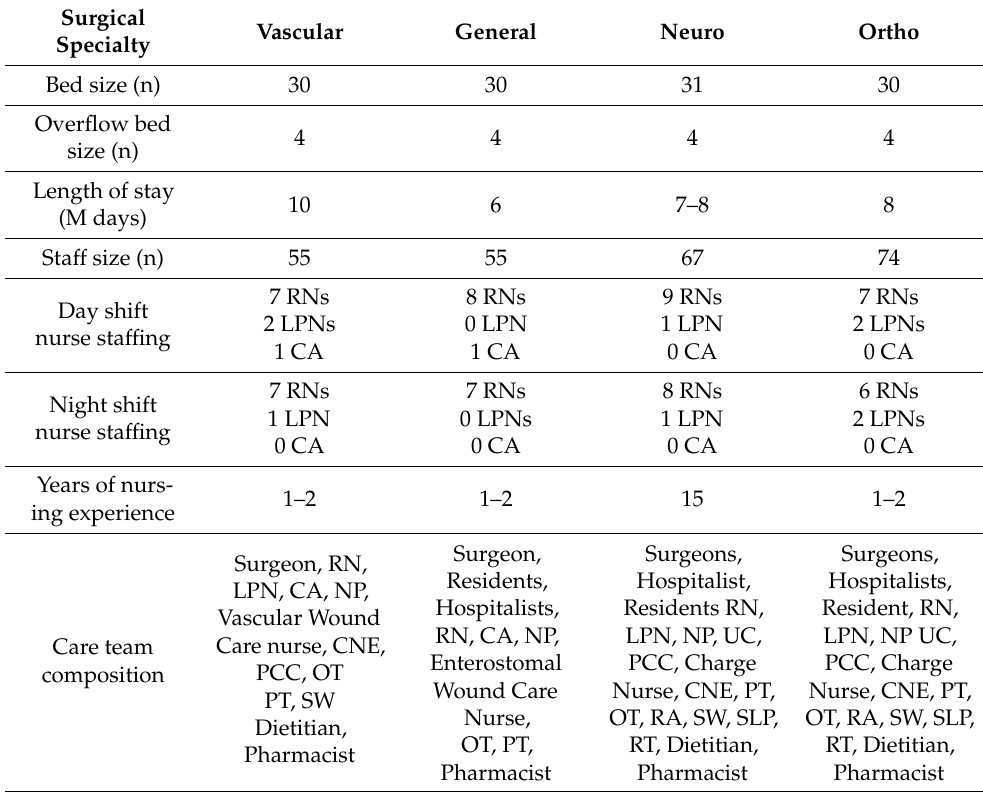
Table 1. Unit Characteristics Based on the Environmental